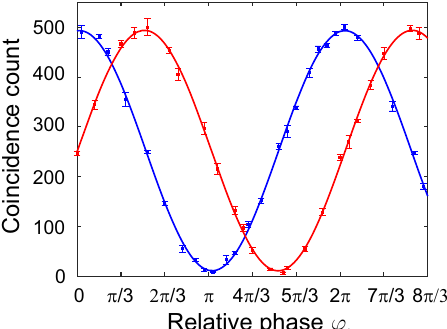
Fig. 3 Two-photon interference fringes for time-energy entangle- ment before QET. The coincidence counts are recorded by varying the relative phase of MZI of idler photons while the phase of the other is set at 0 (blue line) and π /2 (red line). Each coincidence count is measured for 10 s. The error bars represent one standard